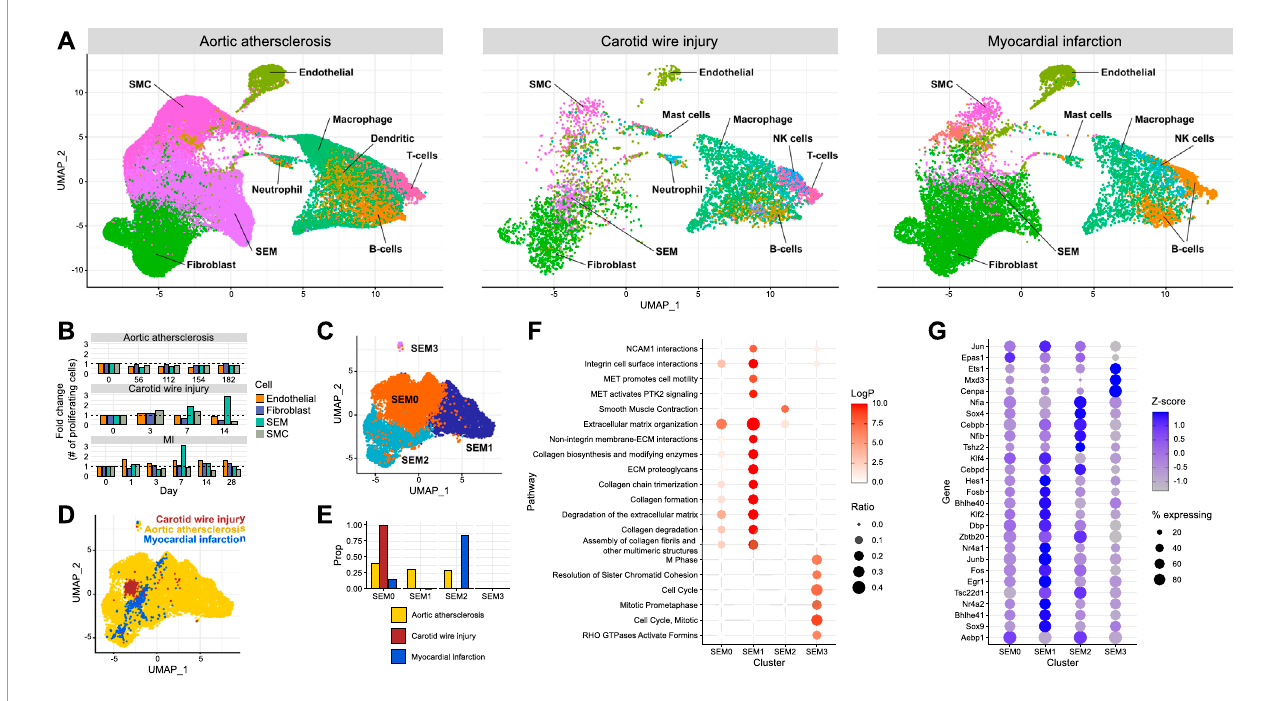
FIGURE 3 Comparison of SEM cells arising from different tissues (A) Integration of scRNA-seq datasets from carotid artery wire injury, aortic atherosclerosis and myocardial infarction. (B) Proportion of proliferating cells of each non-immune cell type across the time course of each scRNA-seq dataset. (C) Re-clustering of SEM cells identified across each of the three datasets, stratified by cluster. (D) Re-clustering of SEM cells identified across each of the three datasets, stratified by dataset of origin. (E) Proportions of SEM cells in each dataset assigned to each SEM cell cluster. (F) Pathway enrichment analysis of each SEM cell cluster. (G) Differentially expressed transcription factor genes in each SEM cell